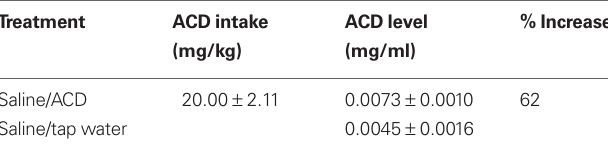
Table 1 | Acetaldehyde blood